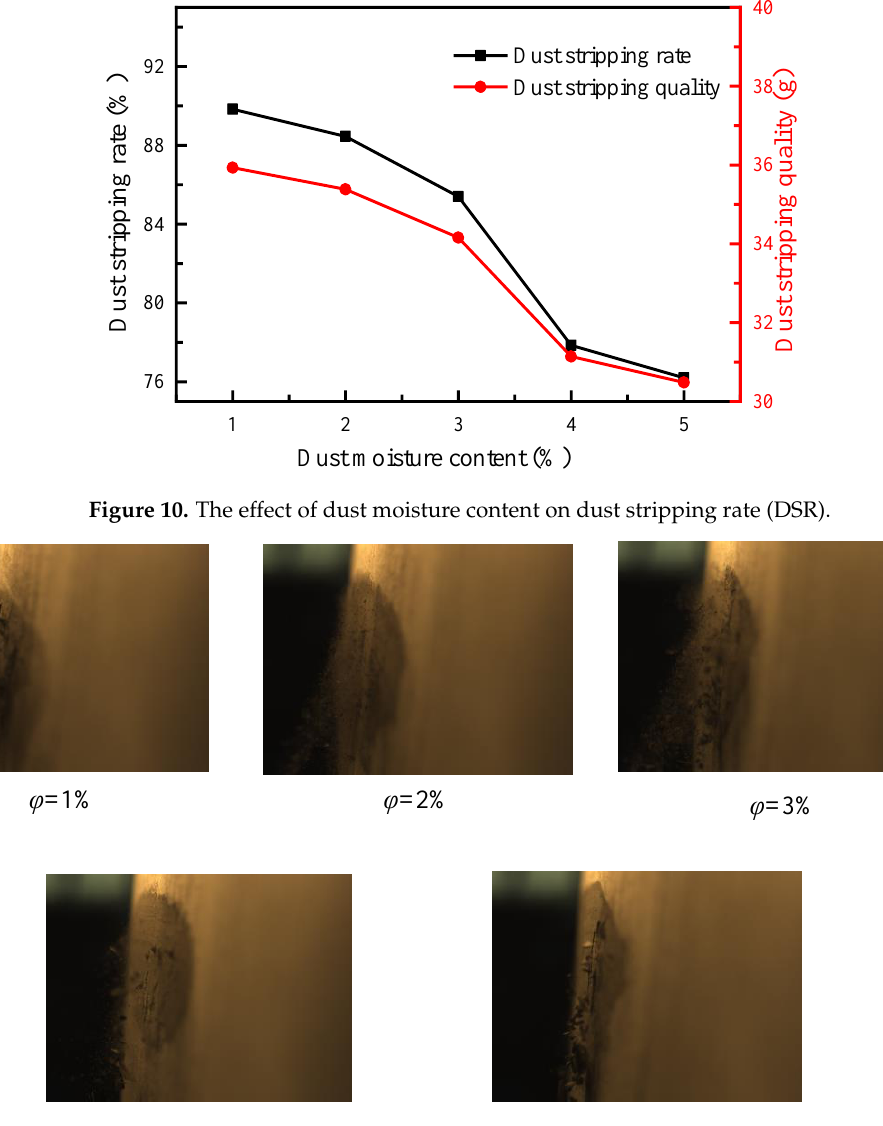
Figure 9. Dust particles with different moisture contents.